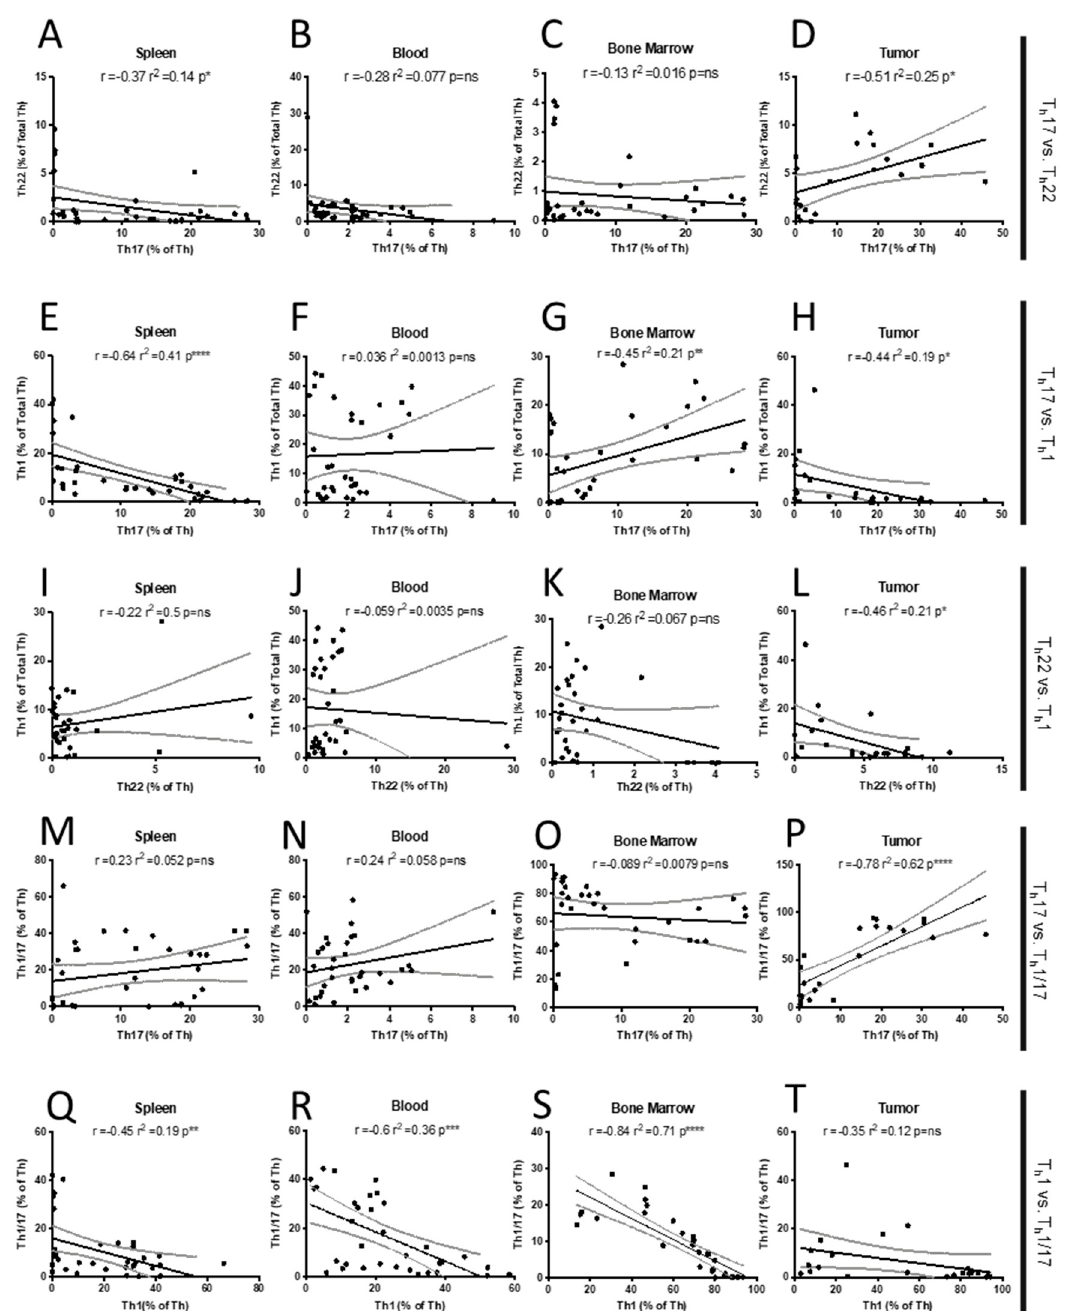
Figure 4. Correlations among T h subsets in 4T1-WT tumor-bearing mice. Pearson correlations between ( A – D ) T h 17 and T h 22, ( E – H ) T h 17 and T h 1, ( I – L ) T h 22 and T h 1, ( M – P ) T h 17 and T h 1/17, ( Q – T ) and T h 1 and T h 1/17 levels in spleen, blood, bone marrow, and tumors in 4T1-WT tumor- bearing mice. Simple linear regression and 95% CI are included to help visualize relationships. p = ns (not significant), * p < 0.05, ** p < 0.01, *** p < 0.001, and **** p <